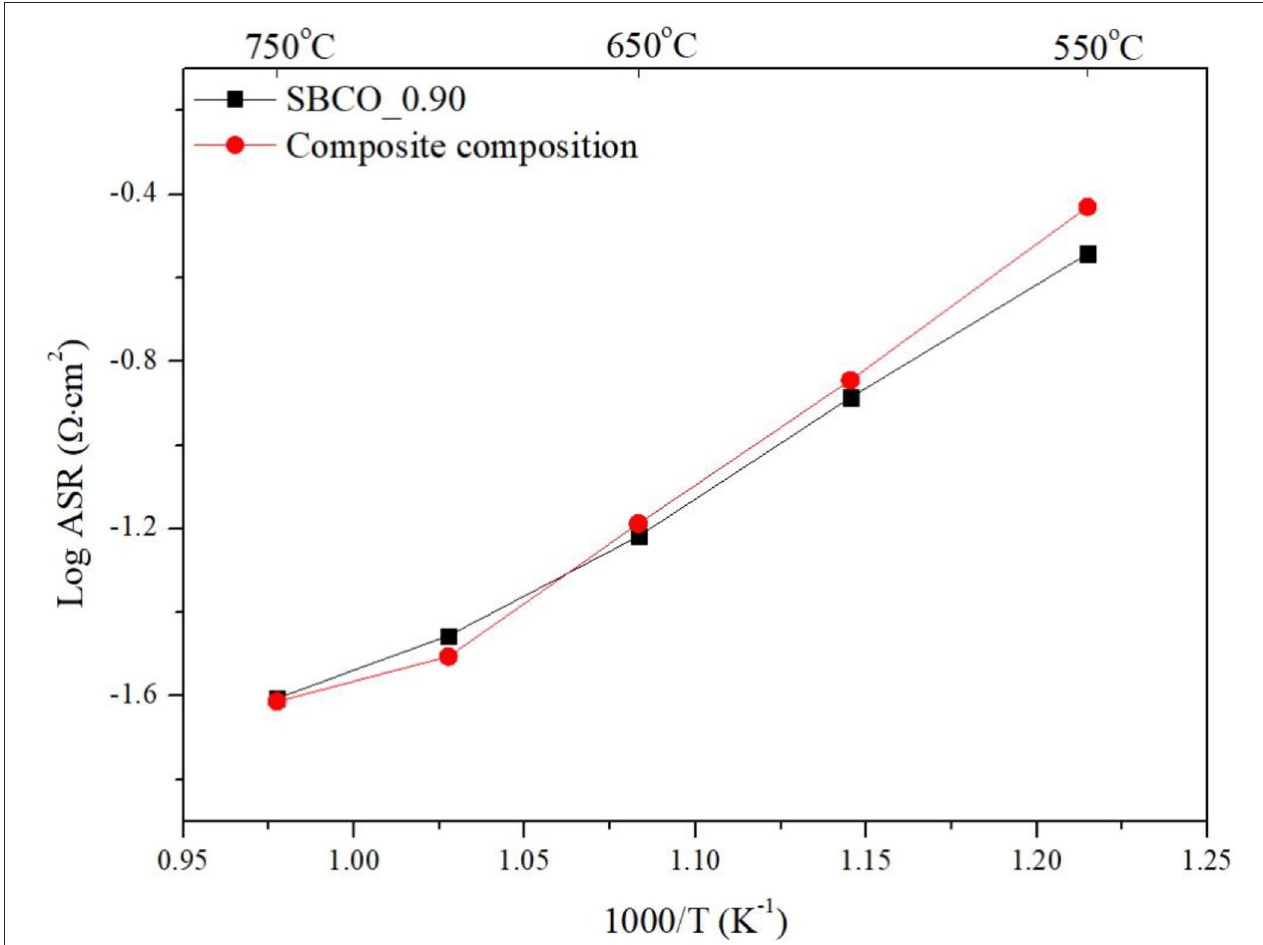
FIGURE 5 | Area specific resistances (ASRs) of SBCO_90 and composite cathode on dense CGO91 electrolyte, measured from 550 to 750 ◦ C. TABLE 3 | ASR comparisons of single phase cathode SBCO_0.90 and composite cathode measured from 550 to 750 ◦ C. Composition 550 600 650 700 750 T( ◦ C) SBCO_0.90 0.271 Composite